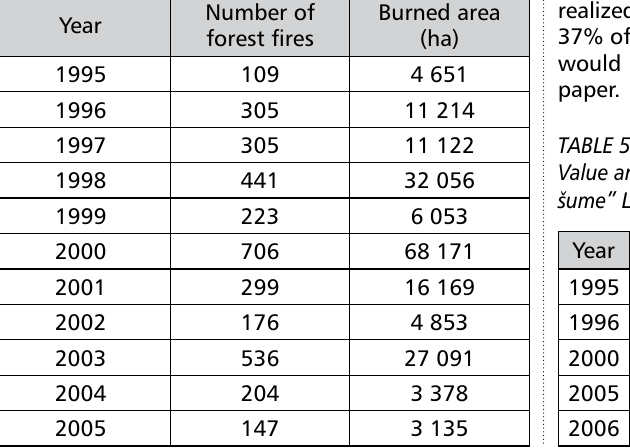
Distribution of forest fires and burned area (based on [17])